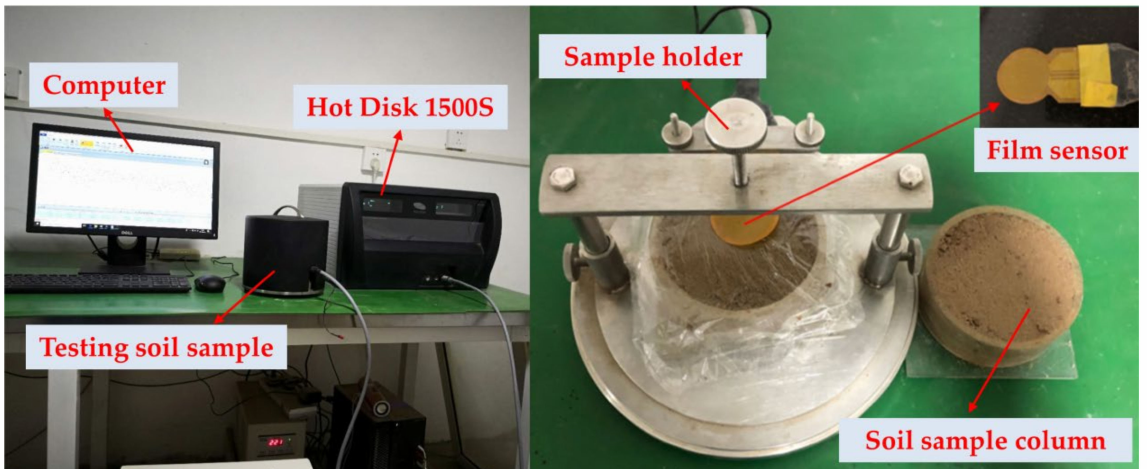
Figure 4. Hot Disk thermal conductivity test